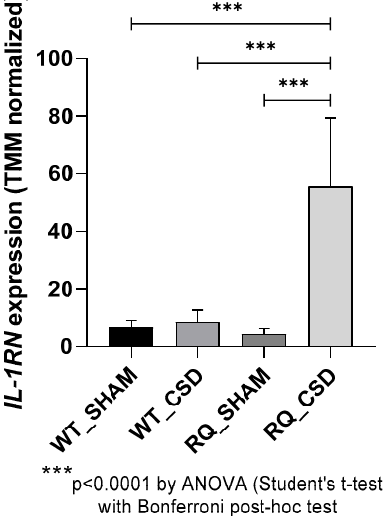
Figure 1. IL-1RN expression in a model of migraine. The expression of IL-1RN was investigated in mice bearing the R192Q mutation and wild–type (WT) mice at baseline and following CSD, as determined in the GSE67933 dataset. Data are presented as trimmed mean of M-values (TMM) normalized expression.